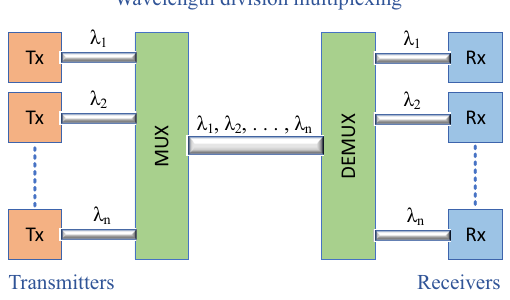
Figure 2. Distributed shared memory.